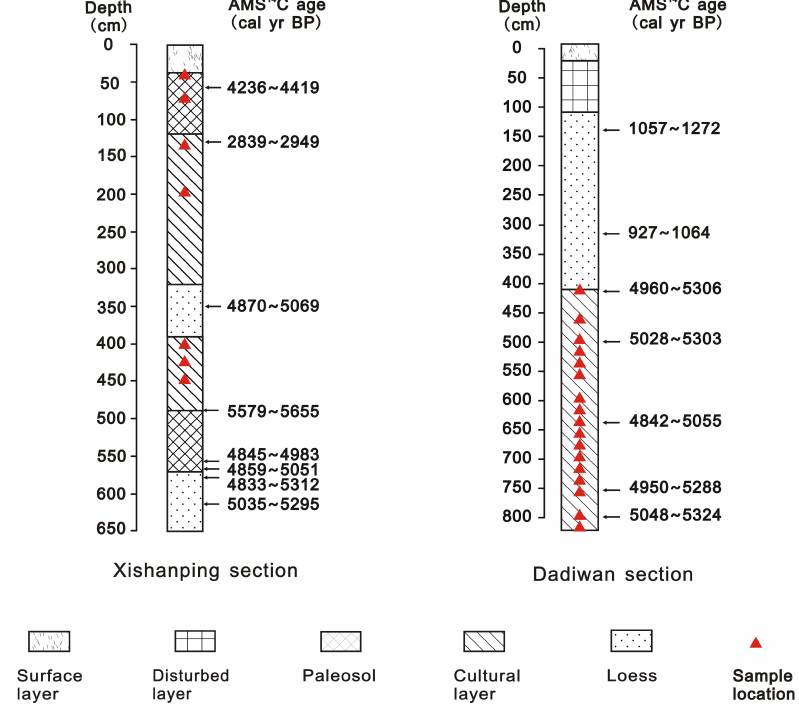
Fig. 2. Stratigraphic sections from the Xishanping and Dadiwan sites and their radiocarbon results.